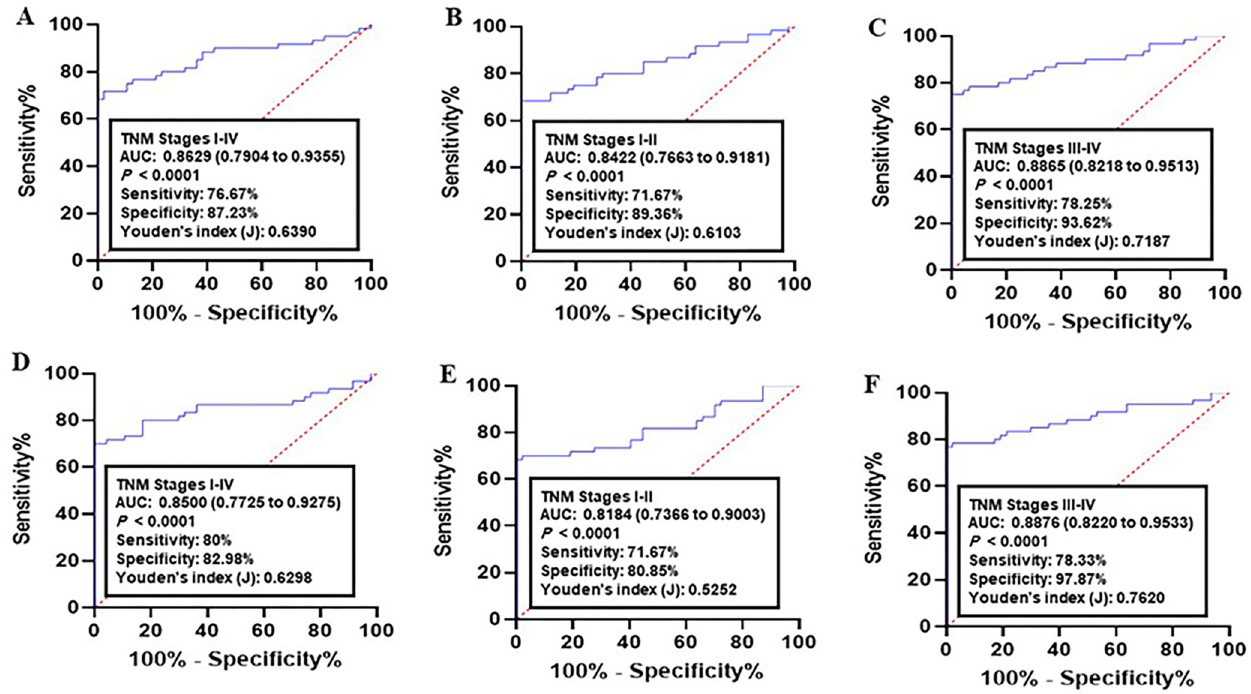
Fig 5. Receiver operating characteristics (ROC) curve analysis of the logit model with the CALU/AURKA/MCM2 panel. (A-C) The area under the ROC curve (AUC) assessment of the logit(p) value for the CALU/AURKA/MCM2 panel in distinguishing (A) lung cancer patients (All TNM stages), (B) early lung cancer (I-II TNM stages), and (C) advanced lung cancer (III-IV TNM stages) from the healthy controls in training set. (D-F) The area under the ROC curve (AUC) assessment of the logit(p) value for the CALU/AURKA/MCM2 panel in distinguishing (D) lung cancer cases (All TNM stages), (E) early lung cancer (I-II TNM stages), and (F) advanced lung cancer (III-IV TNM stages) from the healthy controls in validation set. Logit(p) = 14.1828–0.1955 X (CALU)– 0.1811 X (AURKA)– 0.1857 X (MCM2).